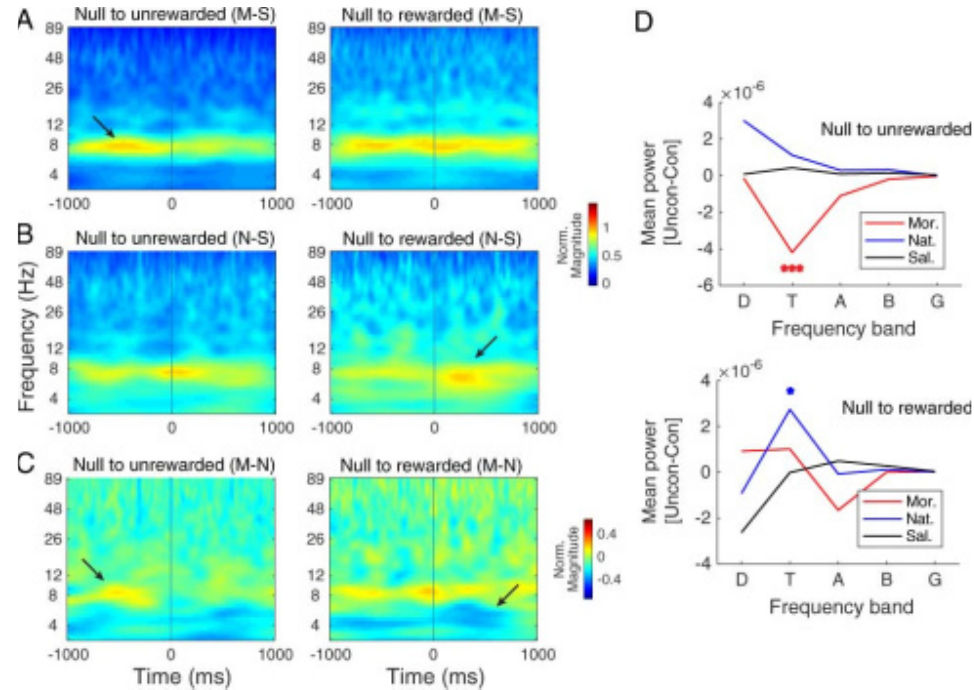
Figure 6. Comparison of hippocampal CA1 local field potential with morphine and natural reward. The left panel shows the time–frequency representation of ( A ) difference between morphine and saline (as control) groups, ( B ) difference between natural (food) and saline (as control) groups, ( C ) and the difference between morphine and natural groups in the time window one second before and after the entrance to rewarded and unrewarded compartments. ( C ) Red indicates greater power of theta frequency before the entrance to the unrewarded compartment (left side), and the blue color indicates greater power theta frequency after the entrance to the rewarded compartment (right side). ( D ) Mean power distributions for saline (black), morphine (red), and natural (blue) reward calcu ‐ lated over a time window of one second before and after unrewarded compartment entry (top) and rewarded compartment entry (bottom). *** p < 0.001 as compared with saline and natural. * p < 0.05 as compared with saline and morphine. 4. Discussion We examined the theta activity of hippocampal CA1 in CPP induced by natural (food, in this case) and drug (morphine, in this case) rewards. Based on our findings, in the animals that received morphine as a drug reward, the approach to the unrewarded compartment was accompanied by enhanced theta activity (theta power) in hippocampal CA1 LFPs, compared with the rewarded compartment approach. In those animals that received food as a natural reward, the CA1 neural dynamic was modulated during the rewarded side approach. The theta power was increased when animals entered the re ‐ warded compartment. The above results point to the conclusion that the hippocampal CA1 theta activity had a different pattern between the null–rewarded and the null–unre ‐ warded sessions during the post ‐ test session of both drug ‐ and natural ‐ CPP. Meanwhile, in the saline group, there is no significant difference between approaches to the rewarded and unrewarded compartments. As mentioned earlier, the rewarded and unrewarded compartments are not only different in terms of the presence or absence of rewards, but also the particular spatial and textural cues defining each compartment. Therefore, the difference between theta activity in the null–rewarded and null–unrewarded sessions is due to the effect of morphine or food as a reward. We also show that drug reward (morphine in this case) and natural reward (food in this case) could differently affect the reward ‐ associated hippocampal CA1 dynamic in the CPP paradigm. The subtracting of the CA1 LFP activity of the saline group from the mor ‐